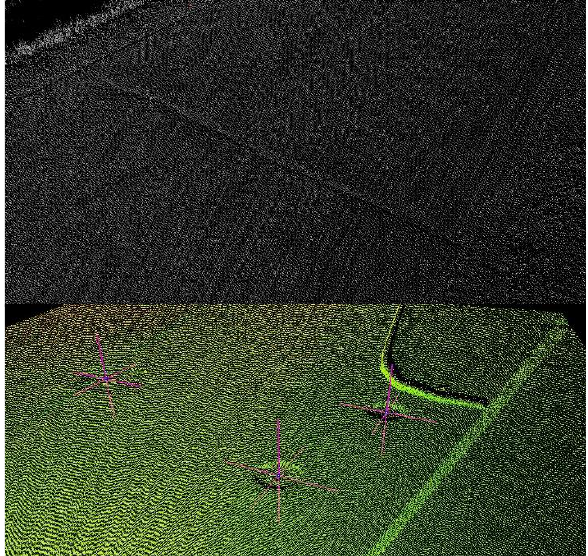
Figure 15. Determination of the size and position of bumps and potholes on the highway point cloud.